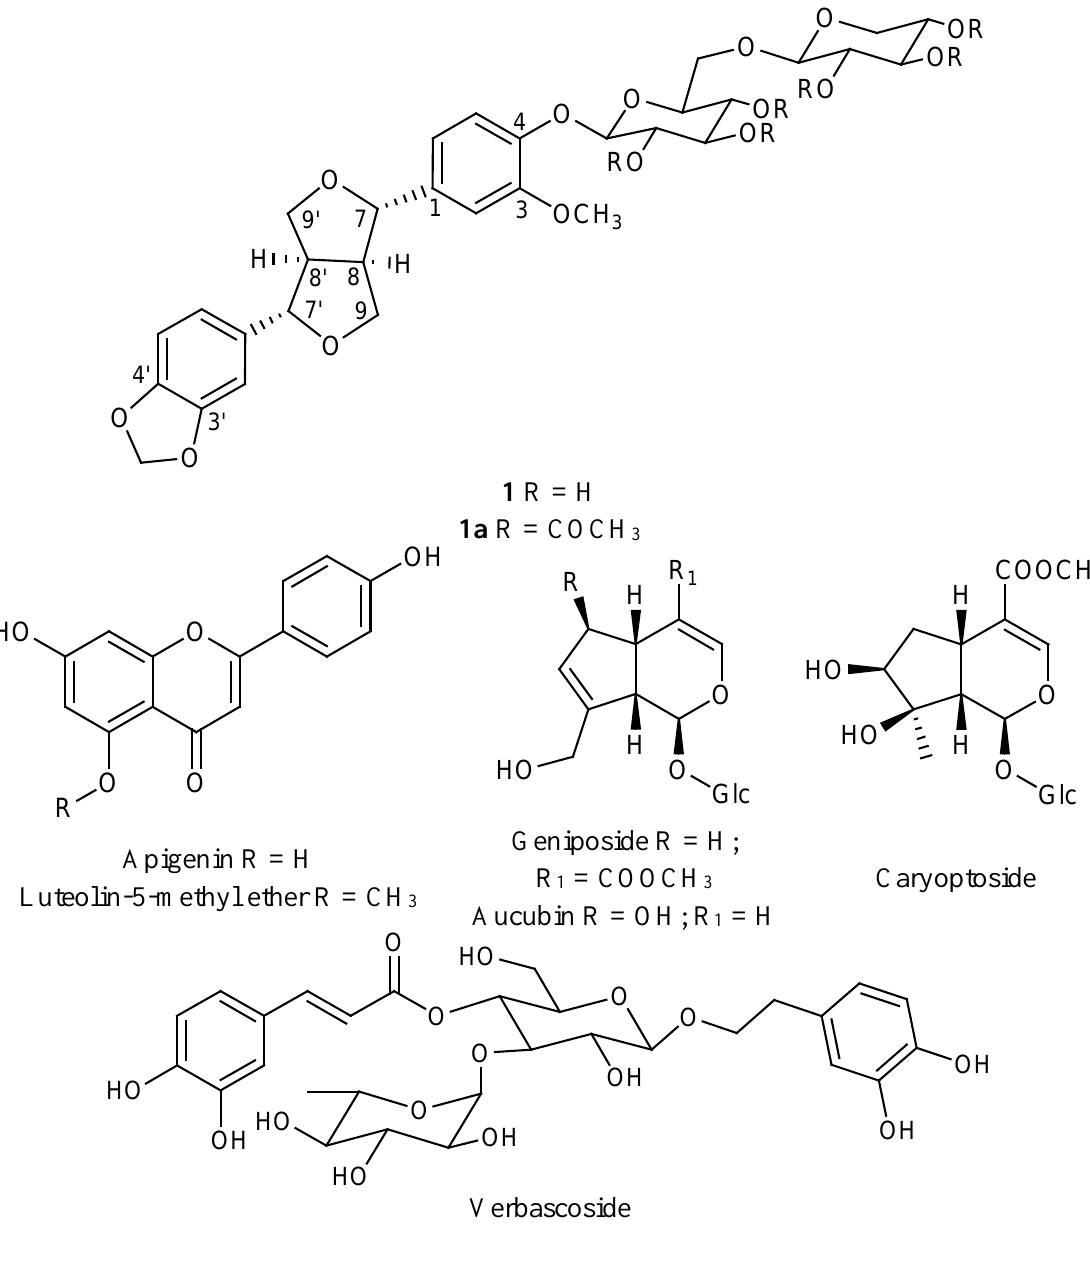
Figure 1. Chemical constituents from methanol extract of C. tenuiflora